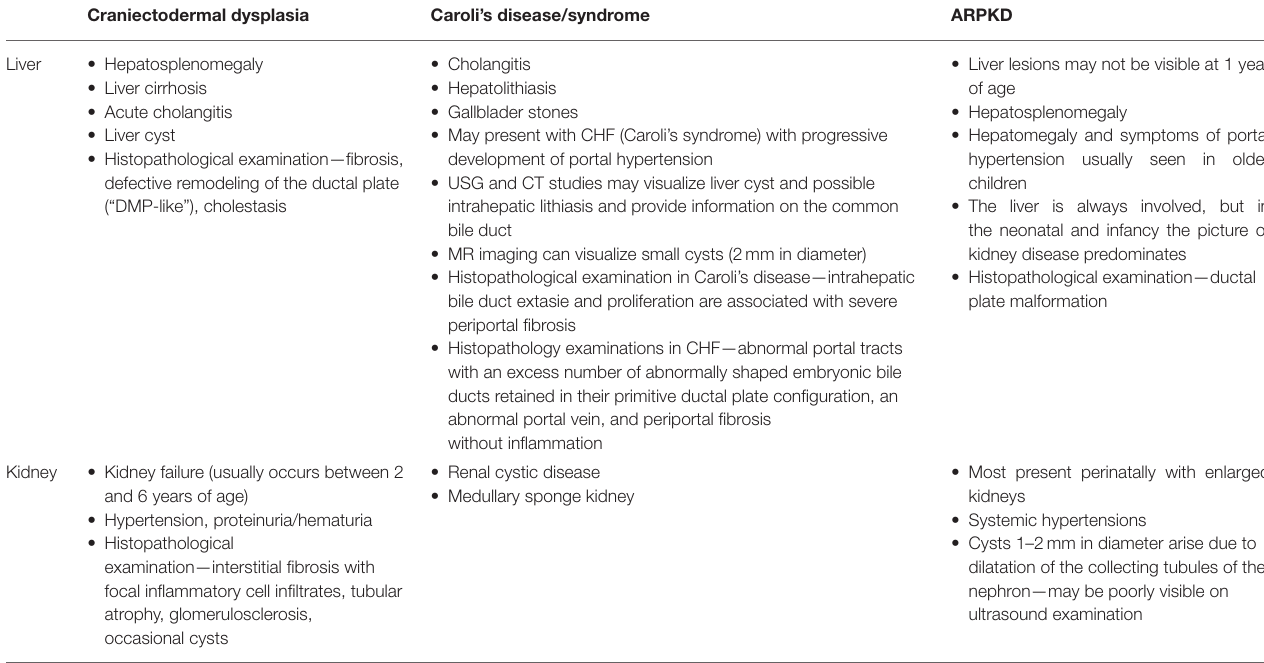
TABLE 1 | Differential diagnostics CED with Caroli’s disease/syndrome and